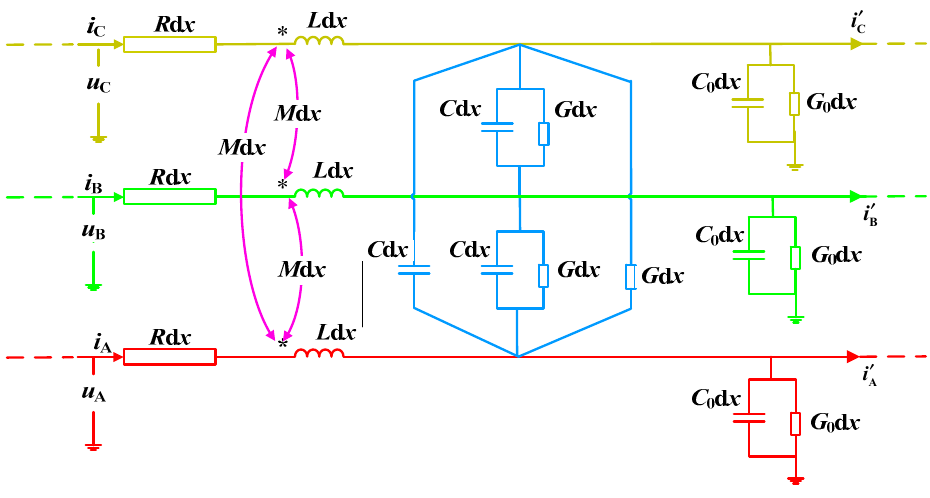
Figure 1. Equivalent RLC-based transmission line segment.